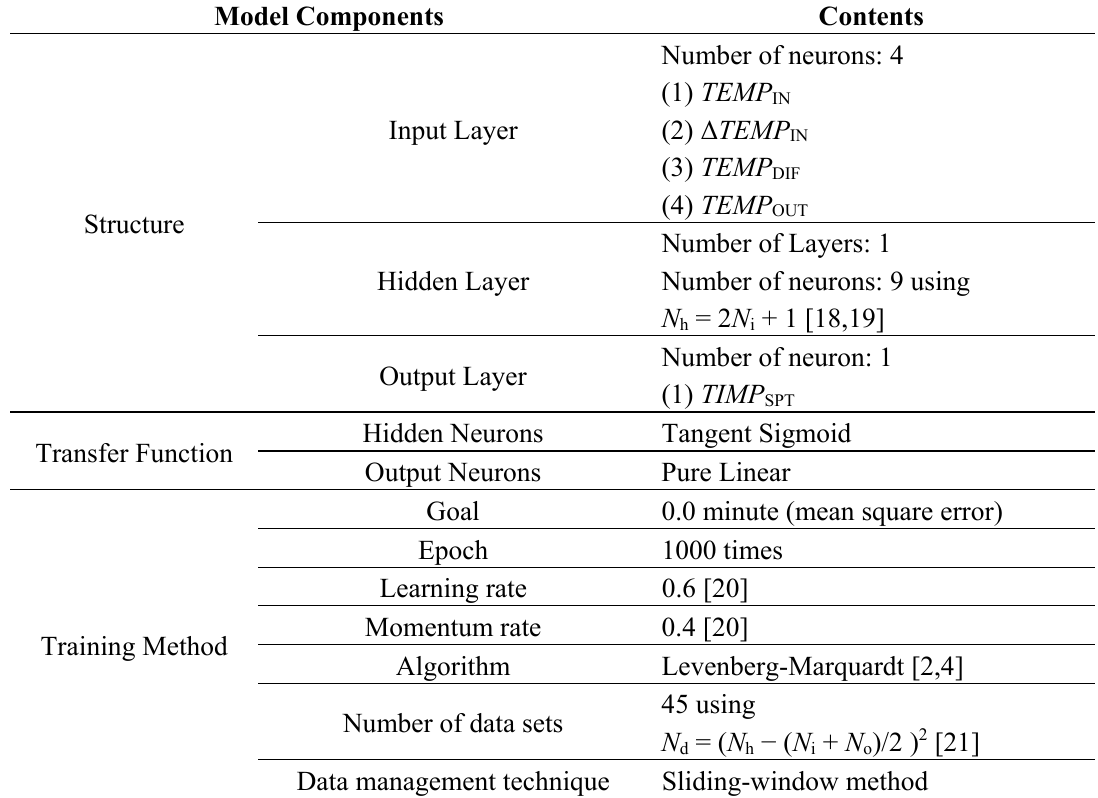
Table 2. Initial composition of the prediction